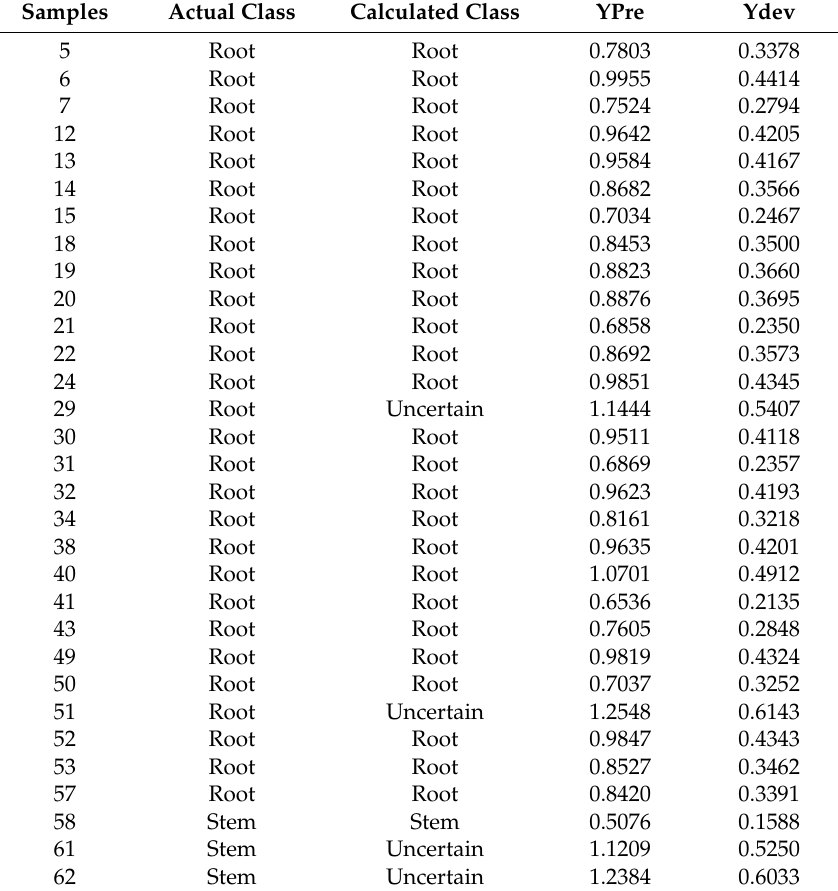
Table 5. Results of PLS-DA model 4 validation set